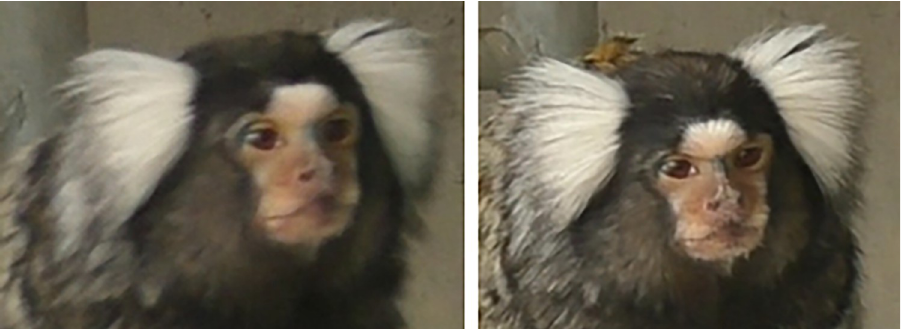
Fig 7. Left: Neutral; Right: AU41—Glabella Lowerer. Still frames from S3 Video.